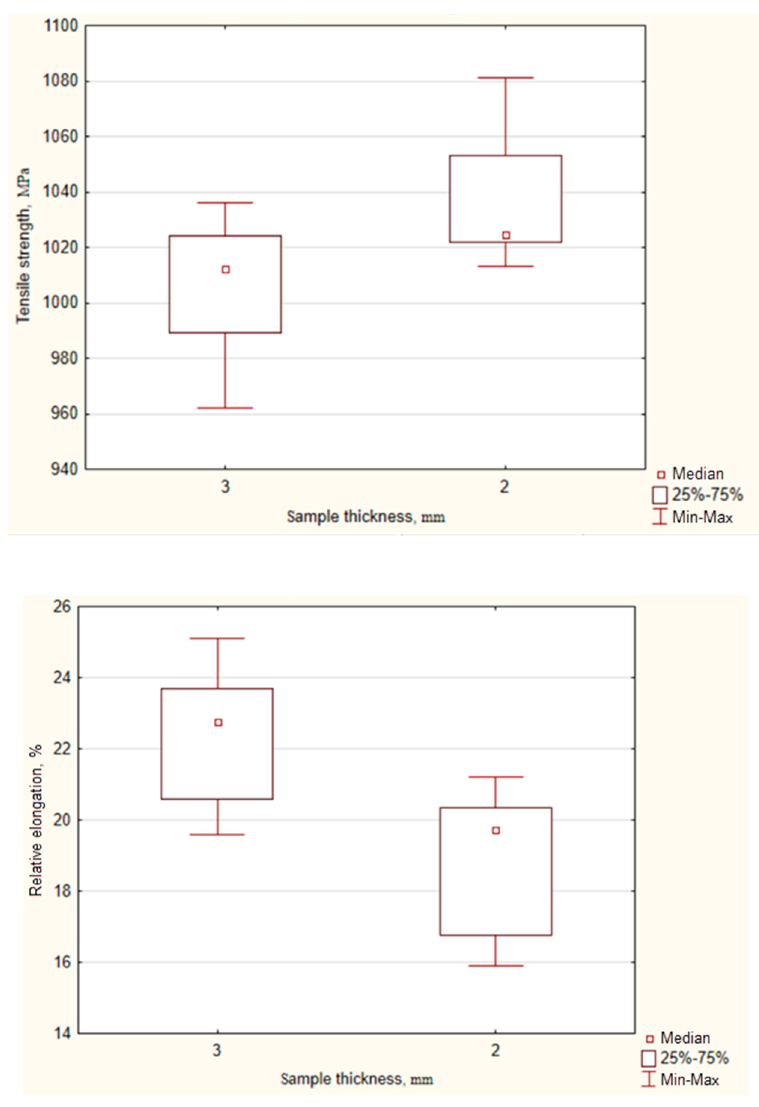
Figure 2. Span diagram for the mechanical properties of LPBF specimens grouped by their thickness. Table 4. Natural logarithms of factors and responses for LPBF flat specimens from